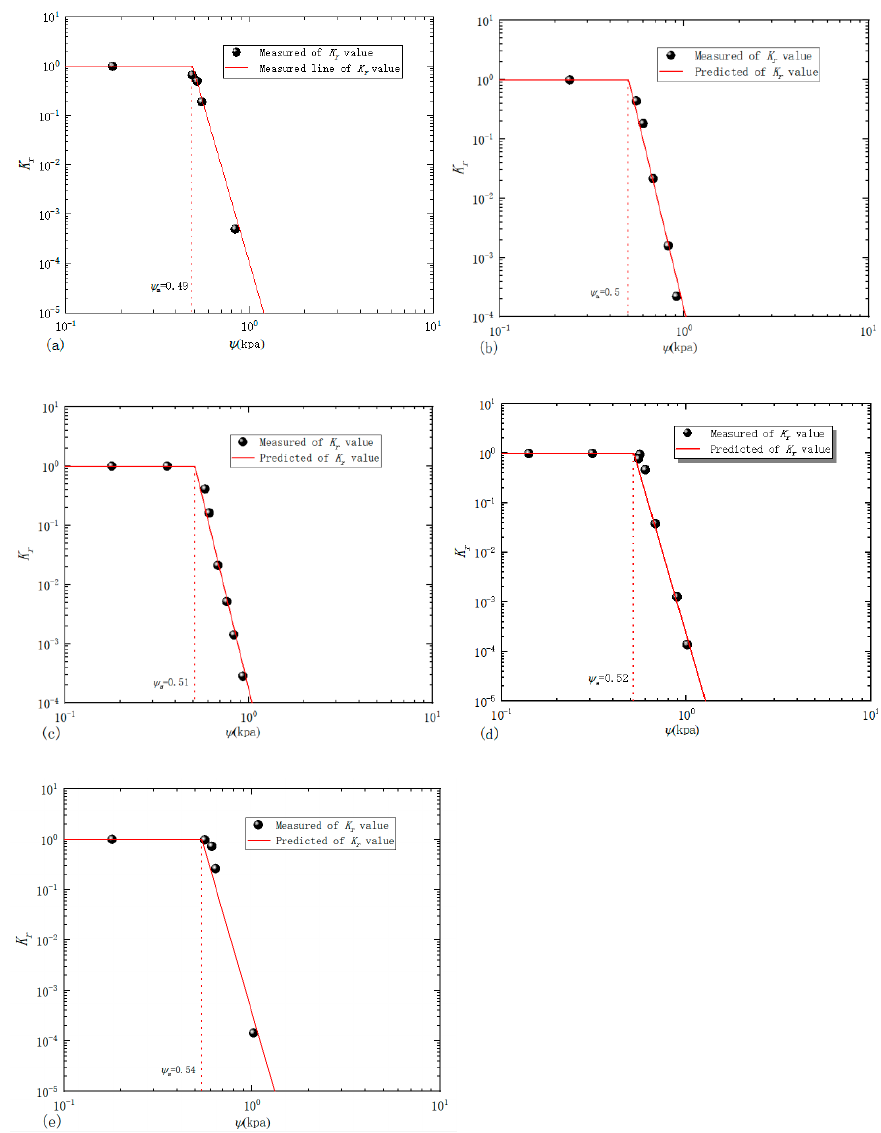
Figure 6. The prediction results of the unsaturated relative permeability coefficients of unconsoildated sand with different porosity ratios: ( a ) e = 0.852; ( b ) e = 0.825; ( c ) e = 0.799; ( d ) e = 0.767; ( e ) e = 0.715.